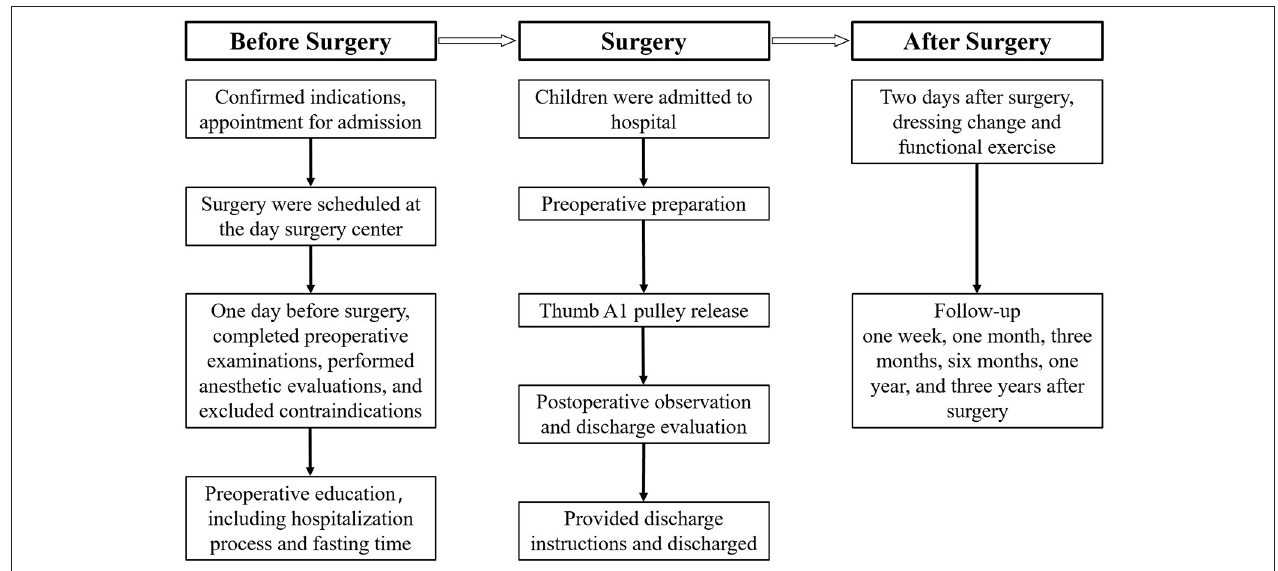
FIGURE 1 | Diagnostic and treatment workflow for day